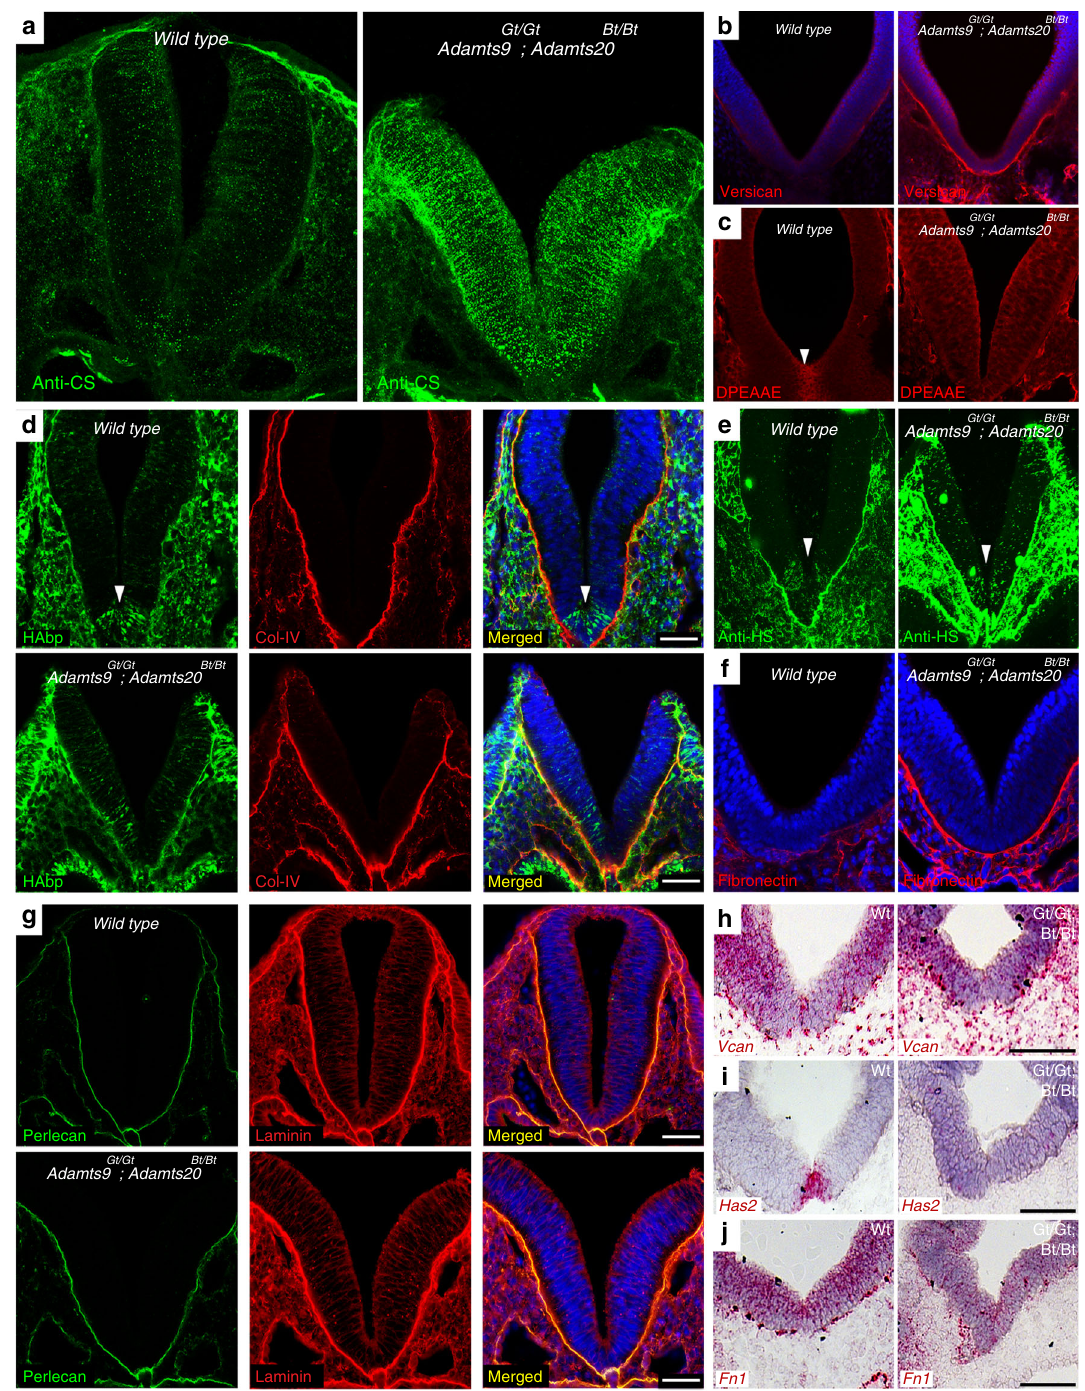
Fig. 7 Abnormal ECM dynamics in Adamts9 Gt/Gt ; Adamts20 Bt/Bt neural epithelium. a 3D-projection of 30 μ m-thick vibratome sections stained for chondroitin sulfate (CS) in E9.5 wild-type and Adamts9 Gt/Gt ; Adamts20 Bt/Bt embryos shows intense CS staining in interstitial ECM of mutant neural epithelium. b Immunostaining for versican (GAG β ) shows stronger staining throughout mutant neural epithelium. c The versican-neo epitope antibody anti-DPEAAE shows strong staining in the midline of the wild-type neural tube fl oor plate (arrowhead) but not in the mutant. d Coimmunostaining with hyaluronan-binding protein (HAbp) (green) and anti-collagen IV (red) shows loss of hyaluronan in the mutant fl oor plate. Collagen IV in the basement membrane of the neural epithelium shows no change in the mutant. e Anti-heparan sulfate (anti-HS) shows intense staining in the mutant craniofacial mesenchyme around the neural epithelium and to a lesser degree in the neural tube (arrowhead). f Fibronectin is present in wild-type neural tube basement membrane and surrounding mesenchyme where it stains strongly in the mutant. g Perlecan (green) and laminin (red) show comparable staining of wild-type and mutant basement membranes. Laminin is also present in ECM of the craniofacial mesenchyme. h – j RNA in situ hybridization shows loss of Has2 ( i ) in the mutant neural tube whereas Vcan ( h ) and Fn1 ( j ) expression are unaffected. Scale bars = 50 μ m in ( d – g ), 100 μ m in ( h – j